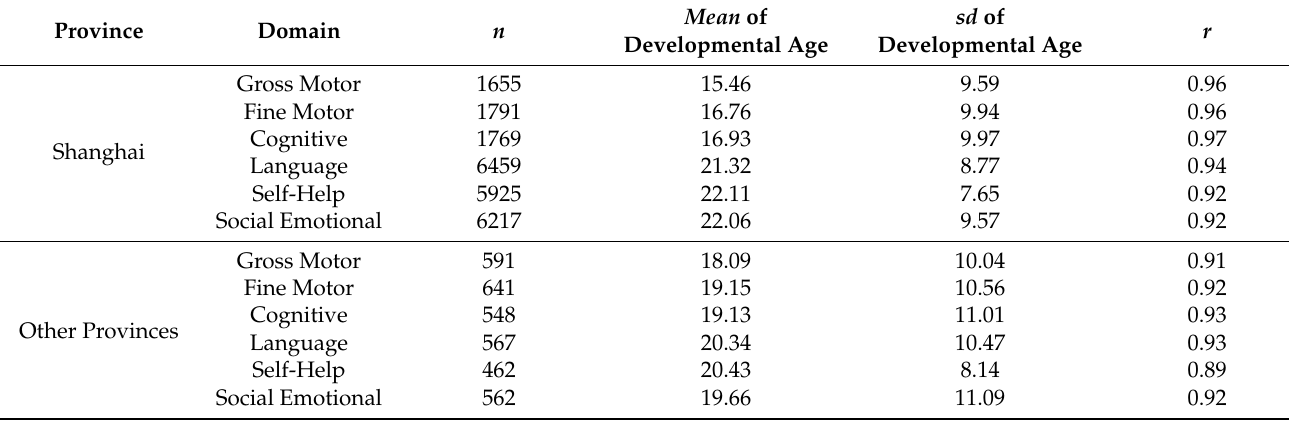
Table 2. Pearson correlation coefficients between developmental age and chronological age from 2013 to 2015, by